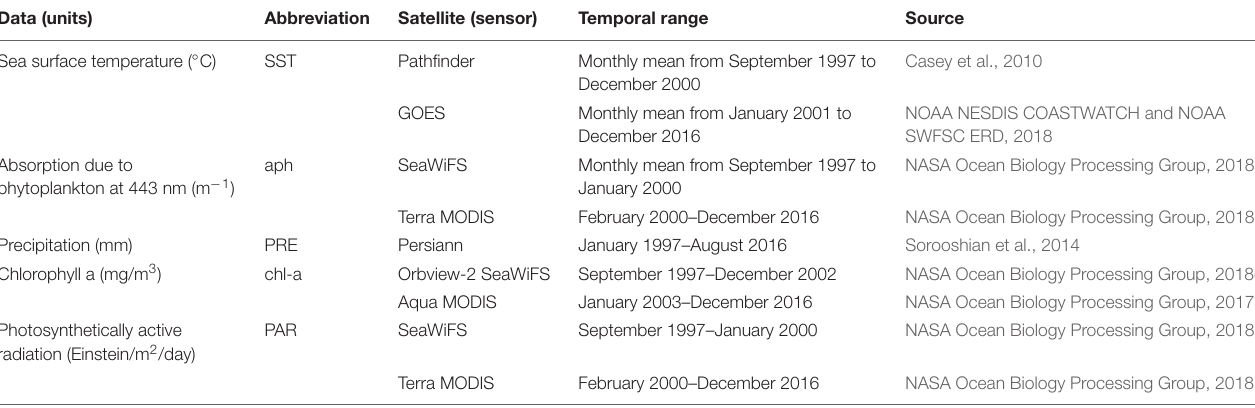
TABLE 1 | Description of oceanographic (SST, aph, chl-a, PAR) and atmospheric (PRE) variables from remote